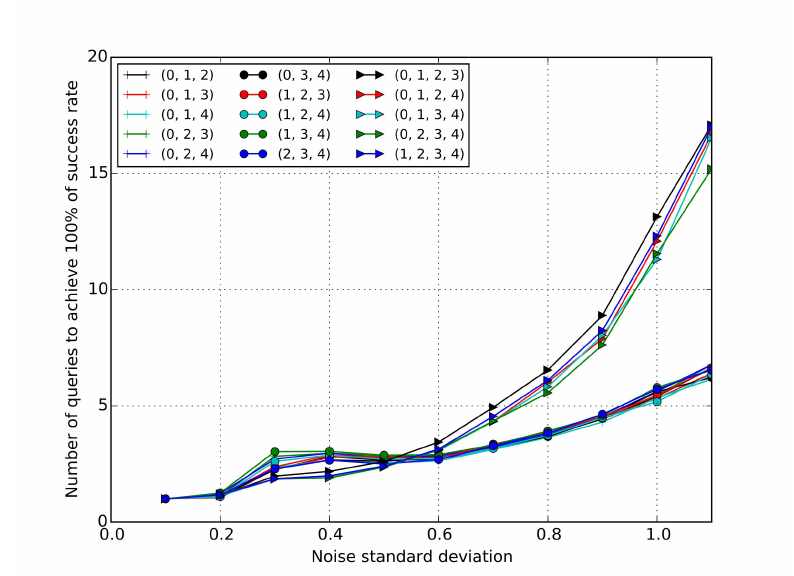
Figure 1: For a (5 , 2)-SSS and different choice of tuples of shares, the number of observations required to achieve a 100% success rate (in y -axis) versus the standard deviation of the noise (in x